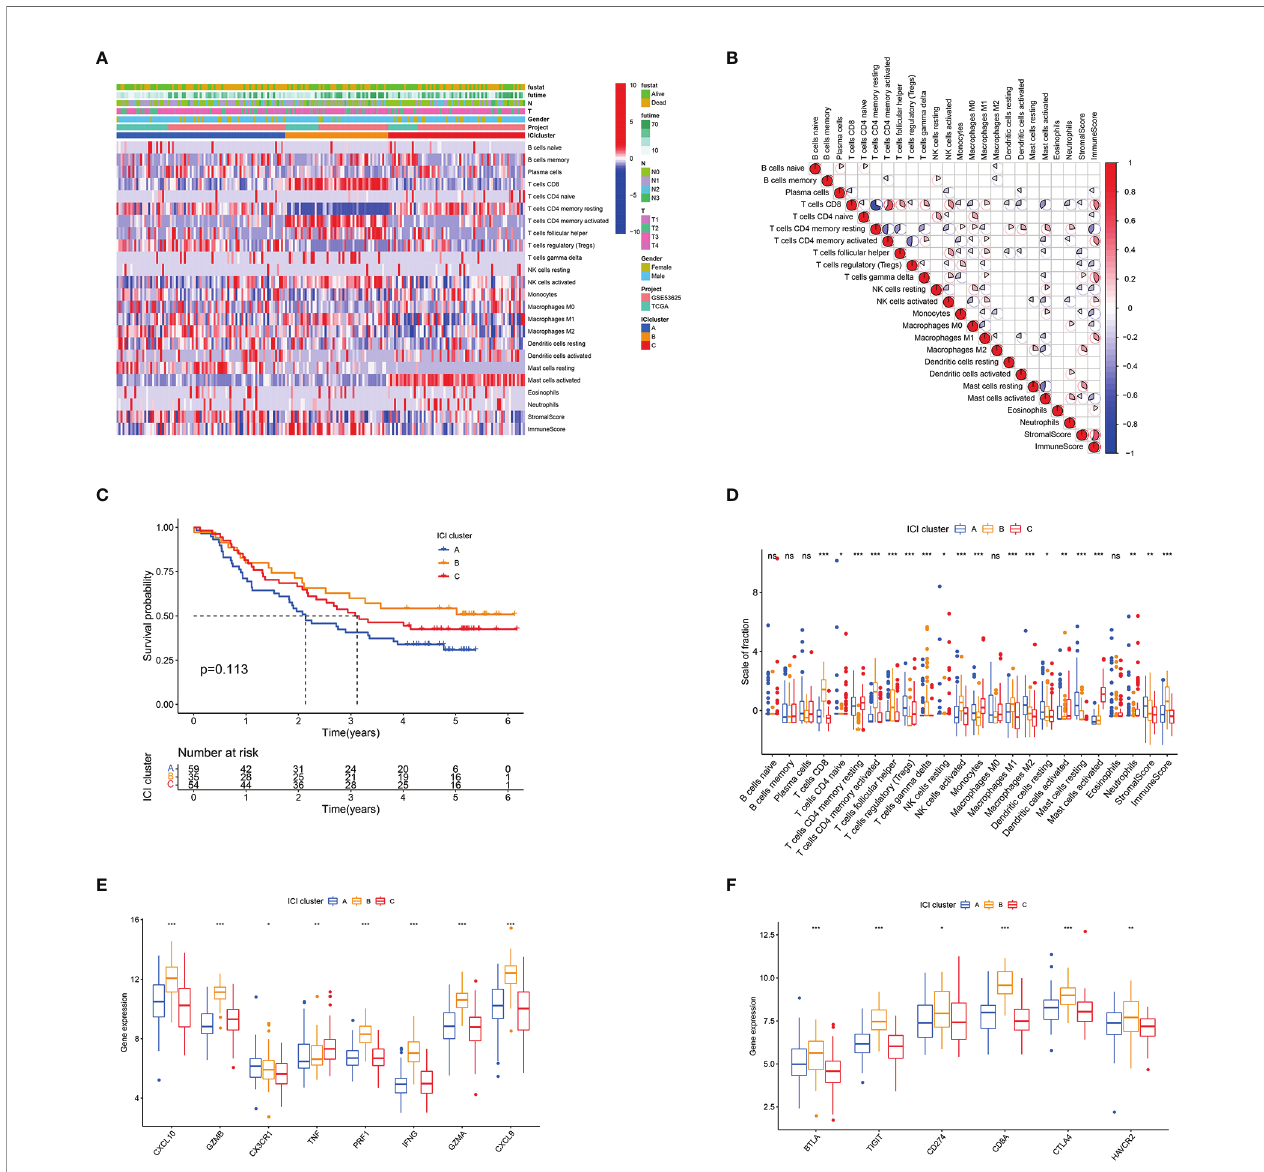
FIGURE 1 | Landscape of ICI in the TME of ESCC. (A) Unsupervised clustering of in fi ltrating immune cells in ESCC samples. Rows denote in fi ltrating immune cells, and columns denote samples. (B) Heatmap of the intrinsic interaction of in fi ltrating immune cells, immune score and stromal score in TME. The colour from blue to red represents negative and positive correlations. The pie chart size represents the absolute correlation coef fi cient. (C) Kaplan – Meier curves for patients with ESCC in ICI clusters A – C. Log rank test P = 0.113. (D) Box plot of in fi ltration immune cell fractions in ICI clusters A – C. The immune and stromal scores of the three ICI clusters are also plotted. (E) Box plot of the expression levels of immune activity-related signature genes ( CXCL10 , GZMB , CX3CR1 , TNF , PRF1 , IFNG , GZMA and CXCL9 ) among ICI clusters A – C. (F) Box plot of the expression levels of immune checkpoint signature genes ( BTLA , TIGIT , CD274 , CD8A , CTLA4 and HAVCR2 ) in ICI clusters A − C. * P < 0.05; ** P < 0.01; *** P < 0.001; ns, no signi fi